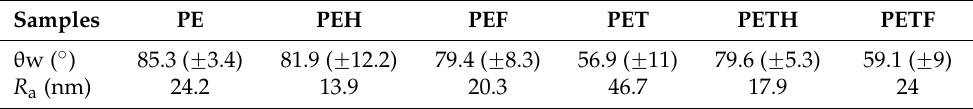
Table 1. Water contact angle ( θ w ) and average surface roughness ( R a )